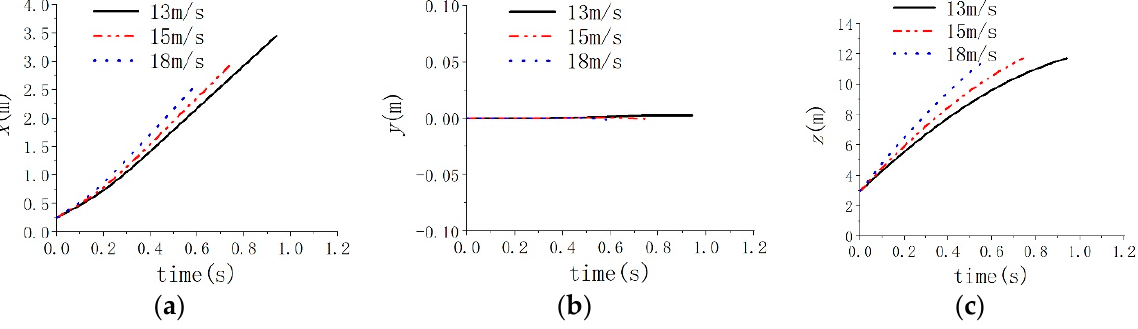
Figure 15. Centroid coordinates of vehicle in case 2, 5, 8. ( a ) Vehicle centroid X -axis coordinates. ( b ) Vehicle centroid Y -axis coordinates. ( c ) Vehicle centroid Z -axis coordinates.